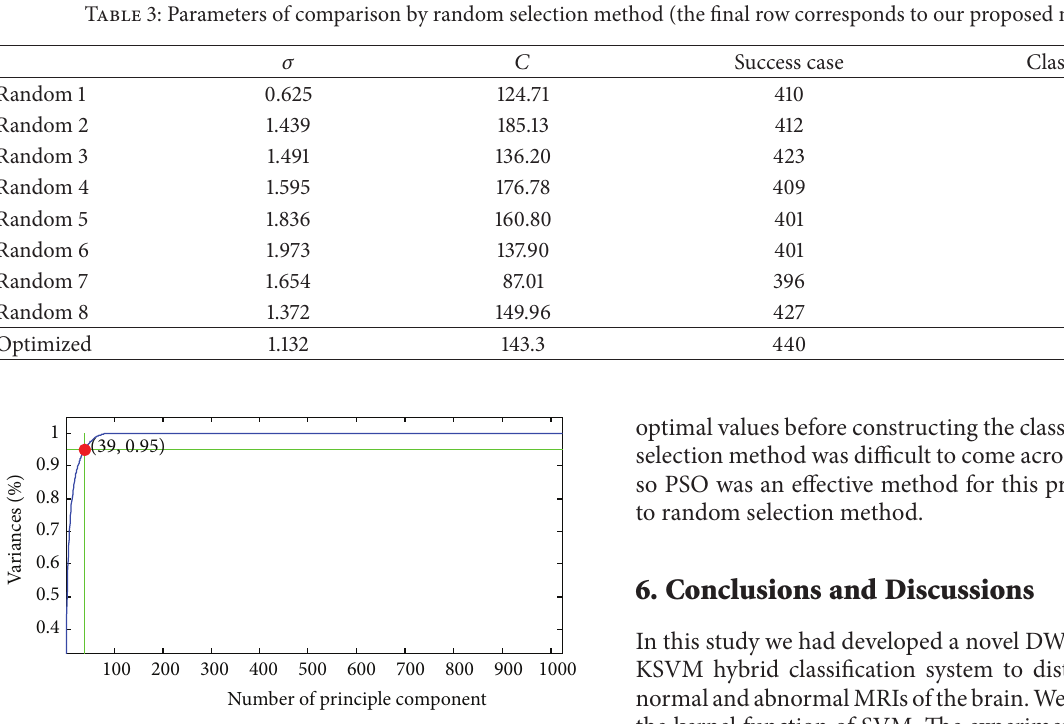
Figure 9: The curve of variances against number of principle components (here we found that 39 features can achieve 95.02%